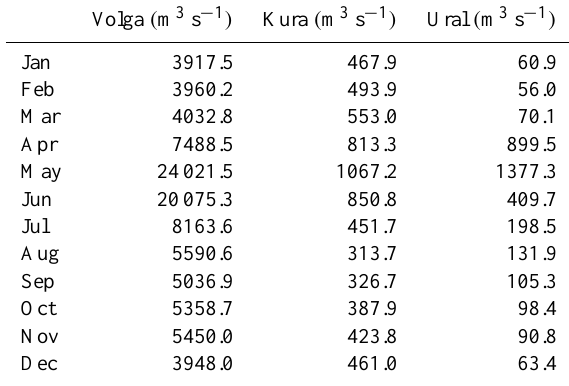
Table 1. Climatological mean flow values obtained from RivDIS (see online at http://daac.ornl.gov/RIVDIS/rivdis.shtml) for the river discharge into the Caspian